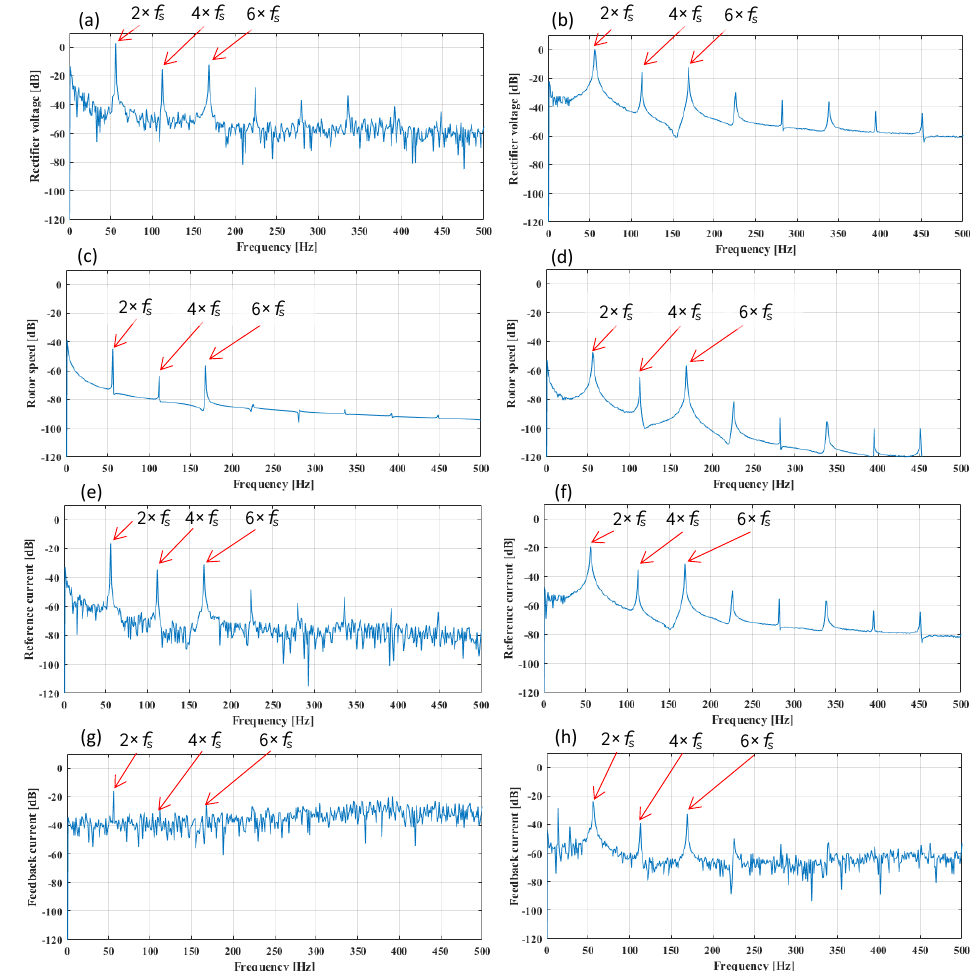
Figure 12. Faulty condition DoS results in frequency domain at the wind speed v w = 10 m/s. ( a ) Three– phase line voltages of PMSG. ( c ) Three–phase stator currents of PMSG. ( e ) Output voltage of the three–phase diode rectifier. ( g ) Rotor speed of PMSG. ( i ) Feedback and reference currents at the input of boost converter. Faulty condition DRTS results in frequency domain at the wind speed v w = 10 m/s. ( b ) Three–phase line voltages of PMSG. ( d ) Three–phase stator currents of PMSG. ( f ) Output voltage of the three-phase diode rectifier. ( h ) Rotor speed of PMSG. ( j ) Feedback and reference currents at the input of boost